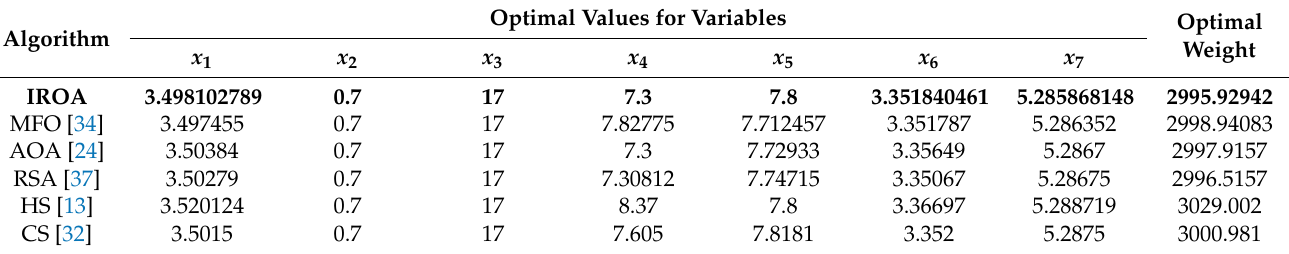
Table 10. Experimental results of speed reducer design problem.